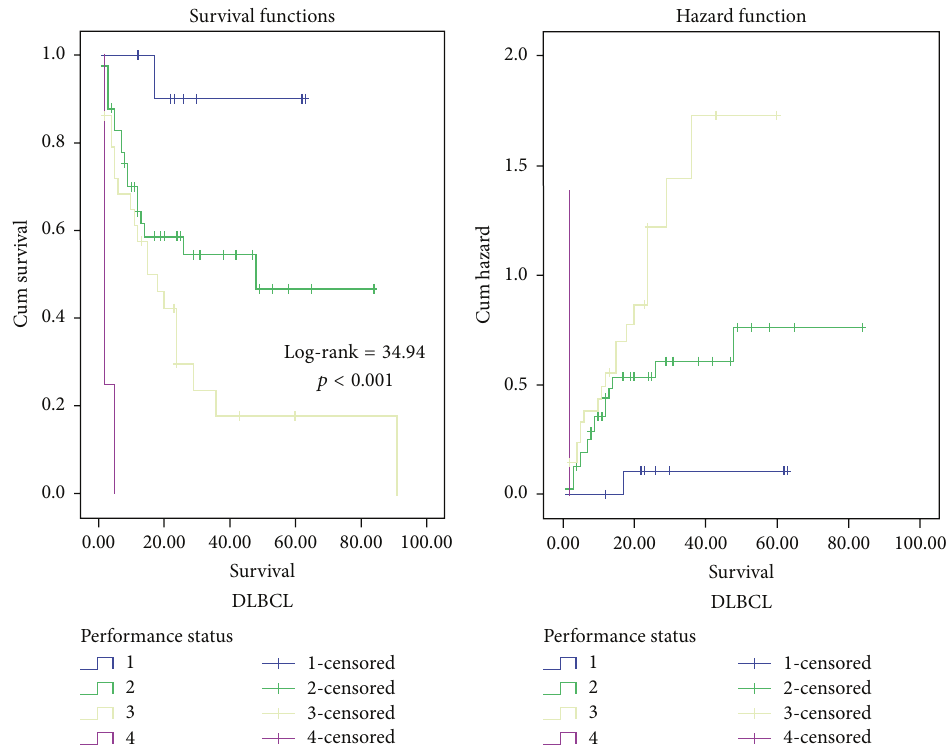
Figure 5: Kaplan-Meier and hazard function curve of overall survival (OS) for DLBCL patients with different categories of performance status (PS) indicating that patients with PS = 4 were more hazardous.